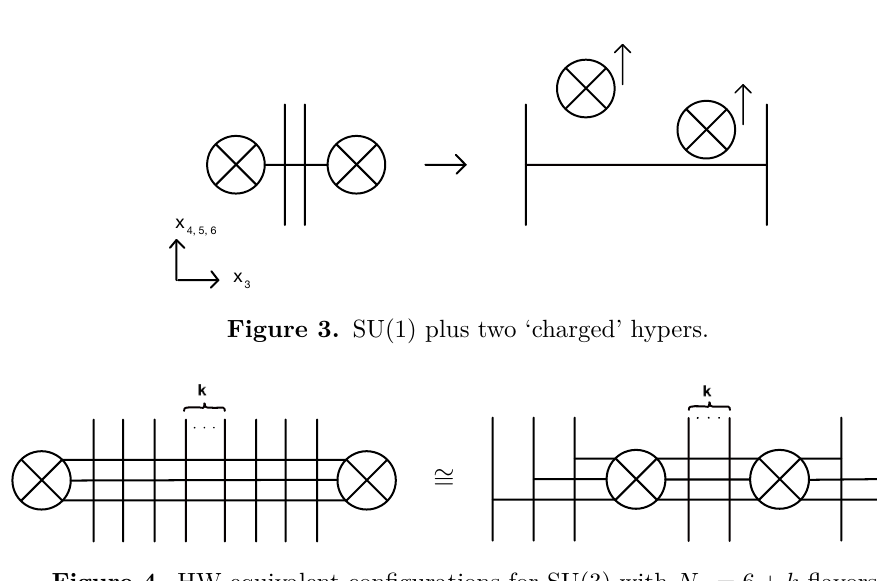
Figure 4. HW equivalent configurations for SU(3) with N f = 6 + k